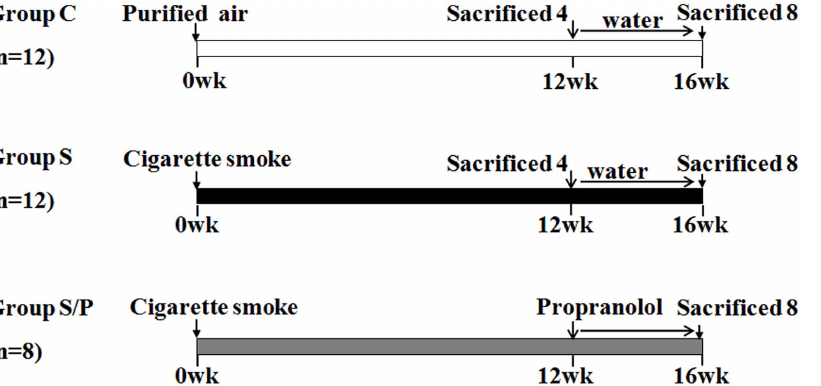
Figure 1. Study protocol. 32 rats were randomly divided into 3 groups for treatment: Group C (n=12): exposure to air and administrated with distilled water as vehicle, Group S (n=12): exposure to cigarette smoke and administrated with vehicle, Group S/P (n=8) exposure to cigarette smoke and administrated with prapronolol. Rats in Group S and Group S/P were exposed to cigarette smoke by a whole-body inhalation instrument generated from commercial cigarettes at 20 cigarettes’ inhalation for 2 h followed by a 4-h recovery, repeated twice a day. Rats were exposed to CS 6 days per week. At 12 weeks later, 4 rats in Groups C and S were killed to evaluate lung function and histopathological alteration, respectively. From weeks 13 to 16, distilled water, 3–5 ml kg 2 1 d 2 1 , was intragastrically administered to Group C, Group S as vehicle, and propranolol, 25 mg kg 2 1 d 2 1 (Kangpu Pharmaceutical Co., China) to Group S/P. The remaining rats were killed after 16 weeks of CS exposure.